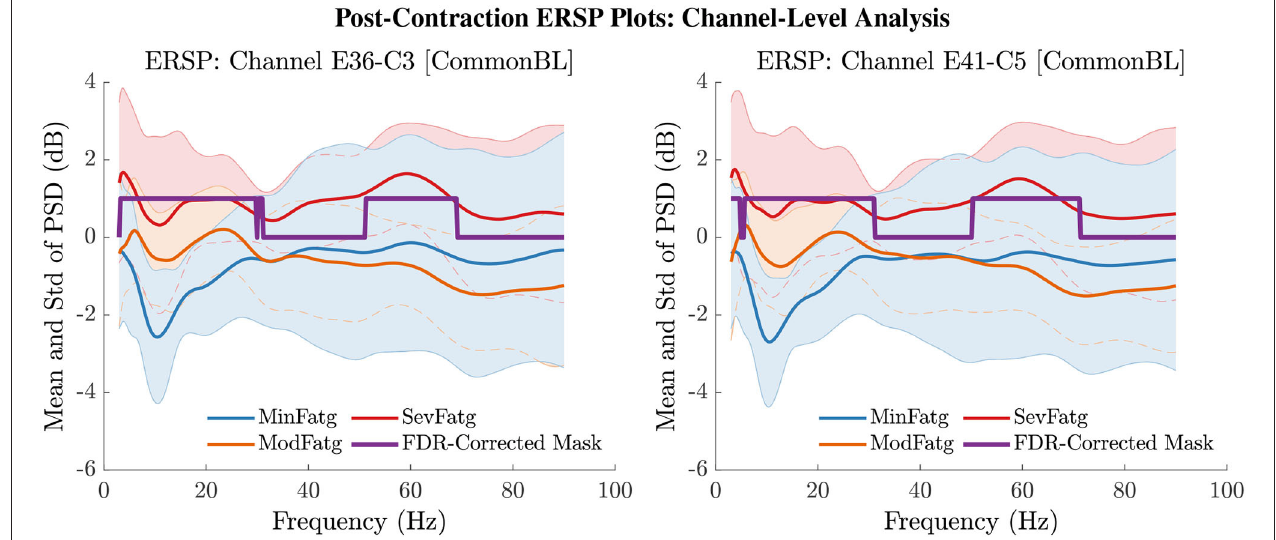
FIGURE 8 | The PSD values in ERSP FatgCond j were averaged over the post-contraction interval of 0.25s to 1.25s to obtain the mean and std of time-averaged PSD for frequencies from 3Hz to 90Hz for the EEG channel C3 (left panel) and C5 (right panel). The FDR-corrected mask illustrates that the PSD values differ between the fatigue conditions at theta-, alpha-, and beta-band frequencies with a statistical significance ( p < 0.05).